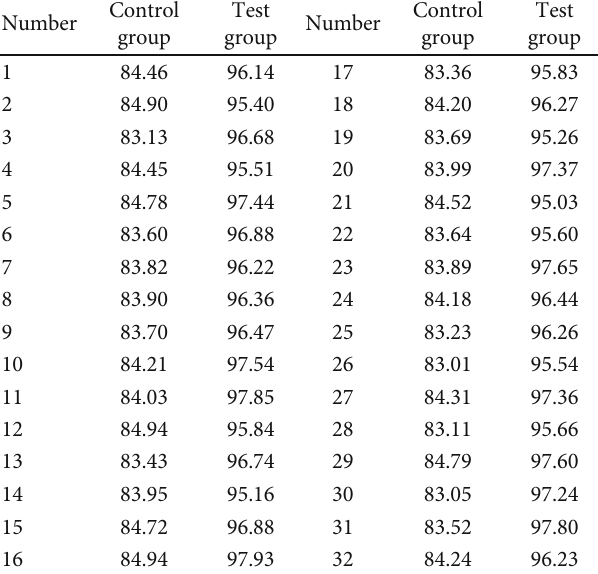
Table 2: VAS score before treatment.